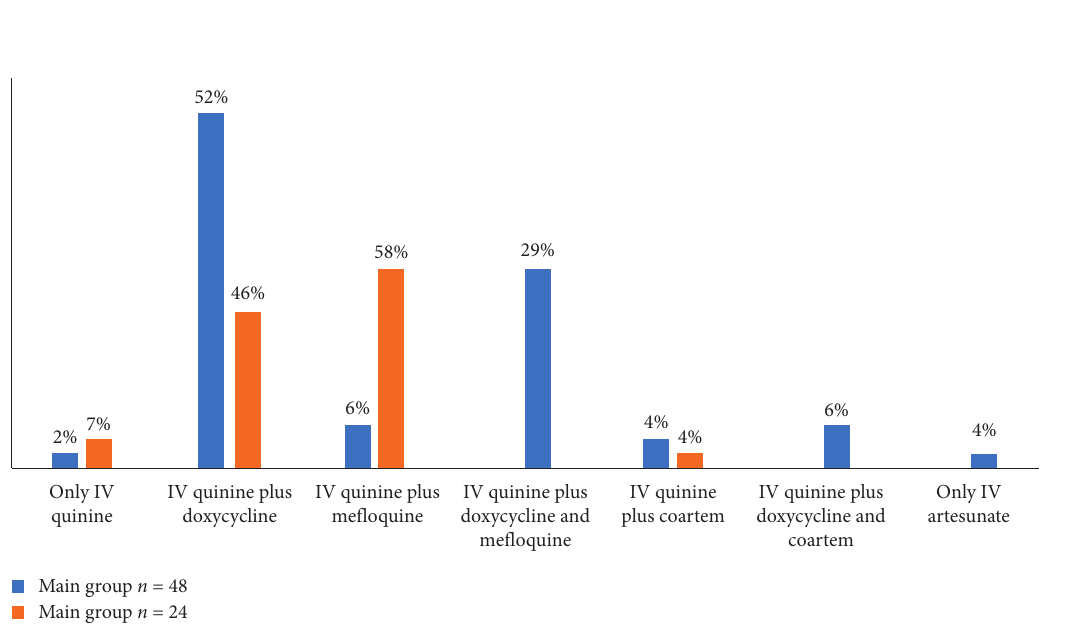
Figure 1: Antimalaria drugs used in patients with severe and complicated P. falciparum malaria.